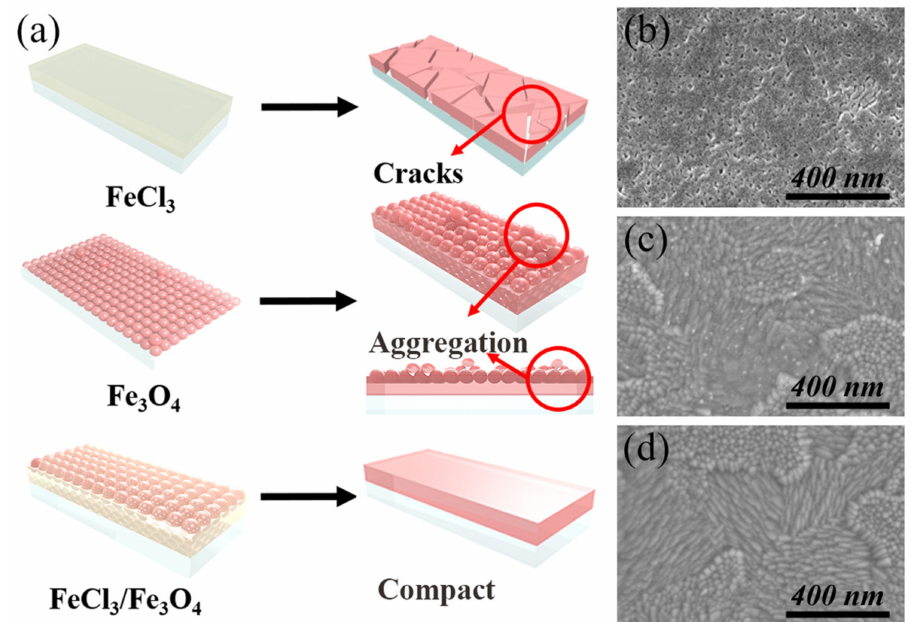
Figure 1. ( a ) Schematic of Fe 2 O 3 films prepared by FeCl 3 solution, Fe 3 O 4 nanoparticles, and FeCl 3 /Fe 3 O 4 mixed solution. Top-view SEM images of Fe 2 O 3 film prepared by ( b ) 0.075 M FeCl 3 solution, ( c ) water-dispersed ten-nm-sized Fe 3 O 4 nanoparticles, and ( d ) FeCl 3 /Fe 3 O 4 mixed